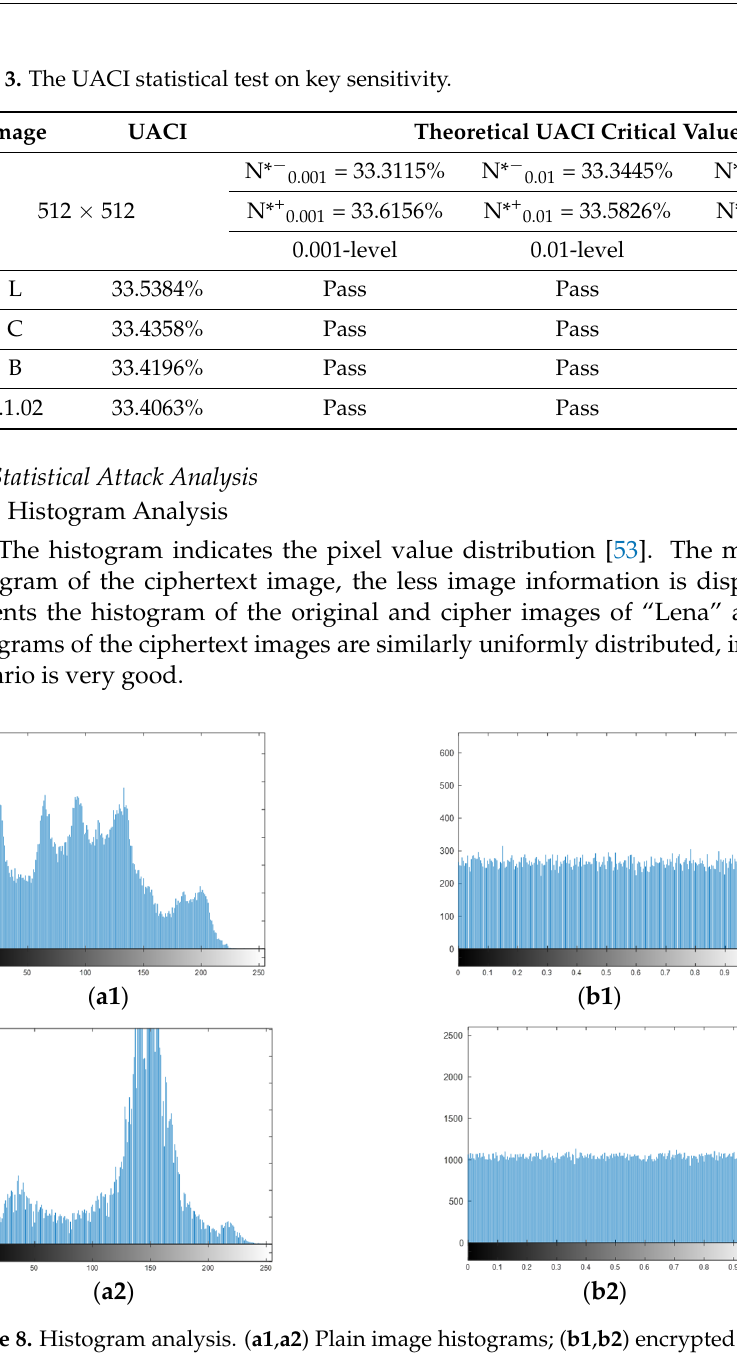
Table 4. Chi-square.